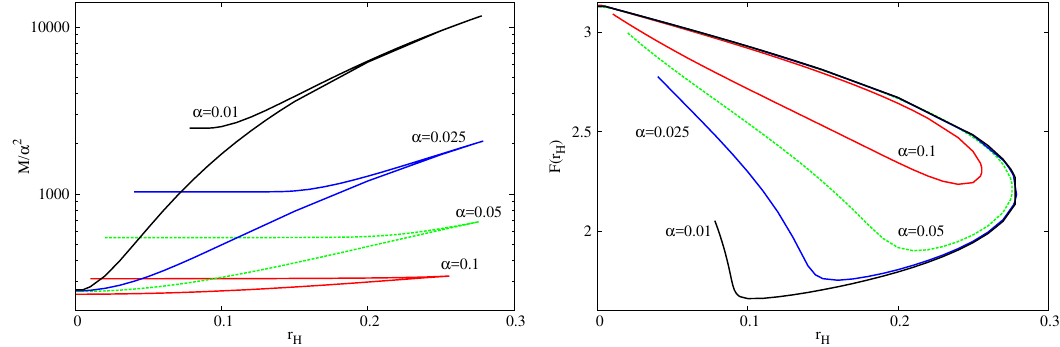
Figure 7 . The mass M (left panel) and the control parameter F ( r H ) (right panel) are shown as functions of the horizon radius r H , for several values of (cid:11)